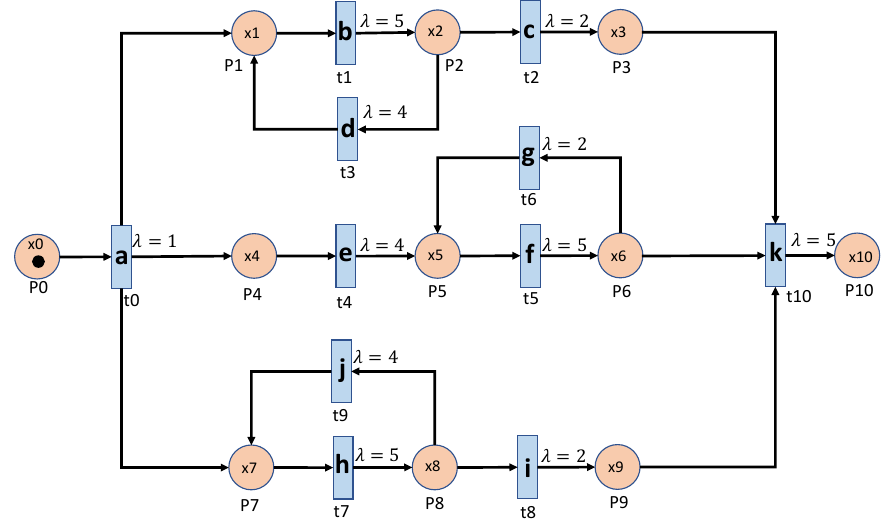
Figure 4. Parallel Loop process with loop events.